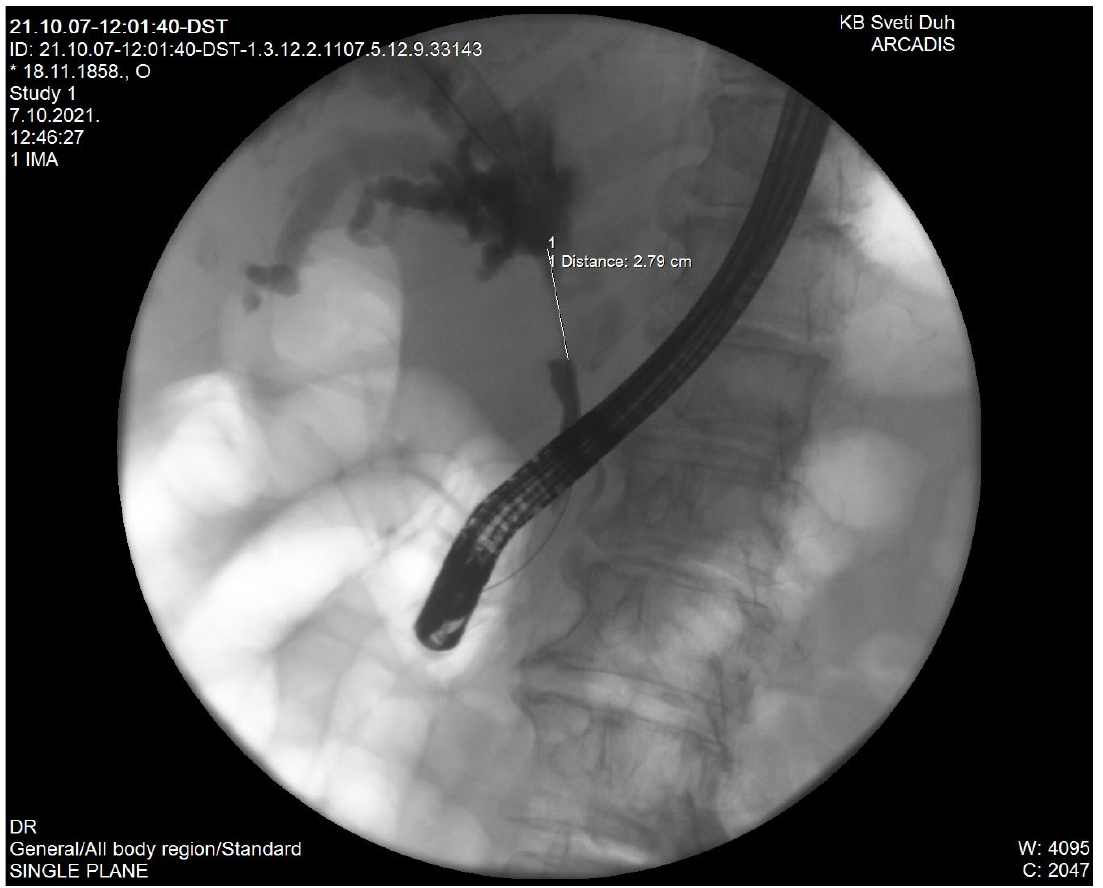
Figure 1. Klatskin tumor on ERCP (ownership of the author).